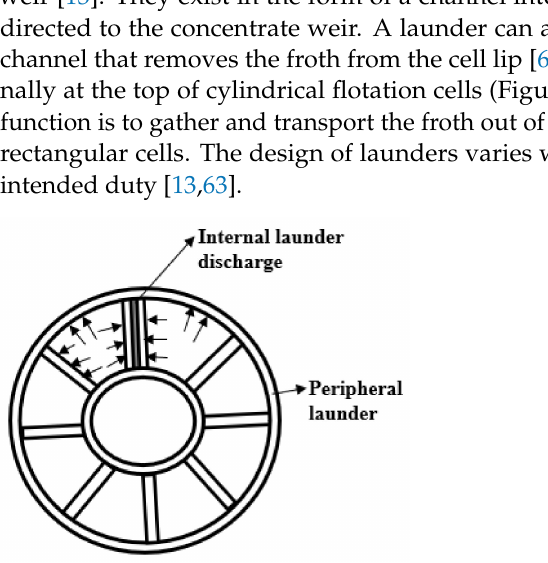
Figure 2. Internal and peripheral launders